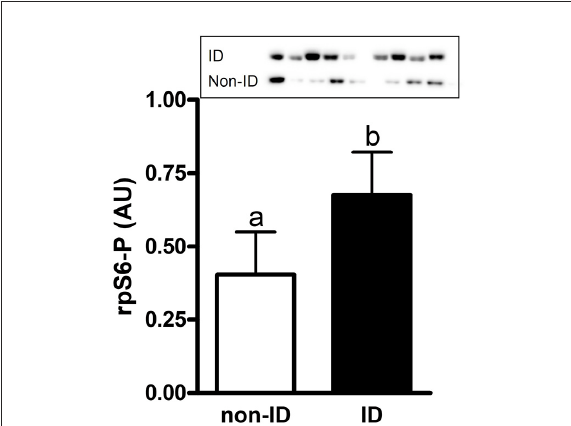
FIGURE5 Relative abundance of phosphorylated rpS6 protein in gluteal muscle samples of ID vs. non-ID horses. Effect of insulin status on overall gluteal muscle abundance of phosphorylated rpS6 protein post consumption of the treatment pellets in ID (black bars, n = 8) and non-ID (white bars, n = 8) horses. Results from two representative blots are shown as an inset. Each lane on the blot represents a time point from the same ID and non-ID horse. a,b Different letters indicate differences between insulin groups. Effect of insulin status, P = 0.007. Values for abundance of phosphorylated rpS6 were normalized to total protein. AU; arbitrary units. Data presented as least square means ± standard error of the